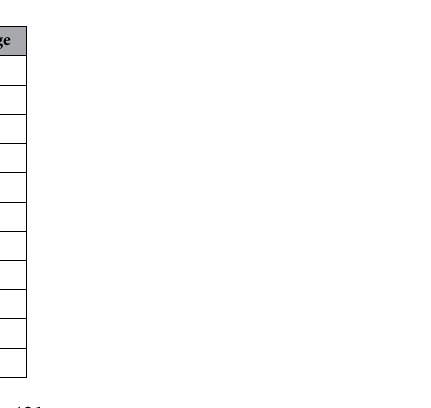
Table 4. Second modification indices of the second CFA. N =